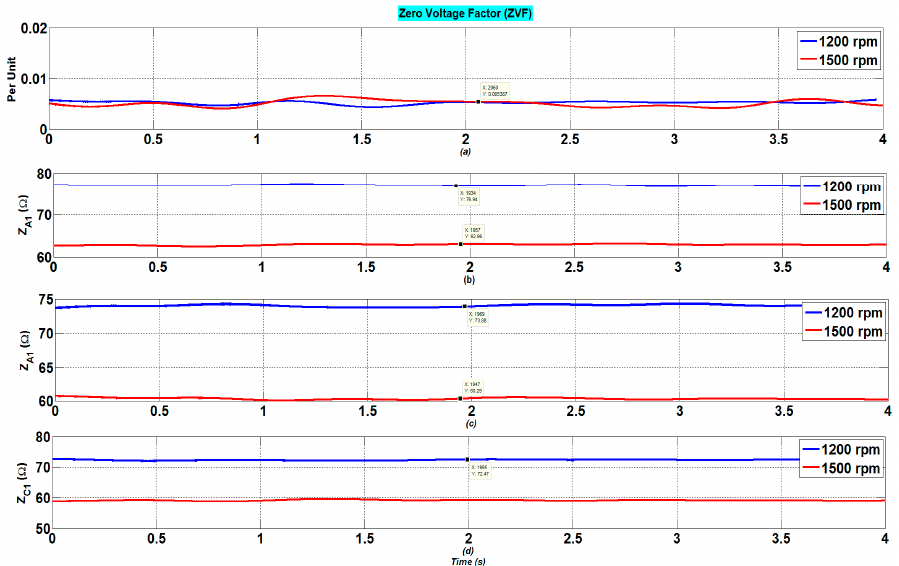
Figure 12. ZVF indicator and estimated impedances with different values of rotation speed. ( a ) ZVF; ( b ) Z A1 ; ( c ) Z B1 ; ( d ) Z C1 .